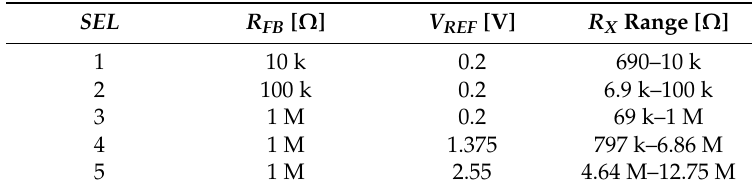
Table 1. The sets of the values of R FB and V REF used in the measurements of R Xdraft . The set used in the measurements is selected with the variable SEL in the software, according to the algorithm presented in Figure 2.